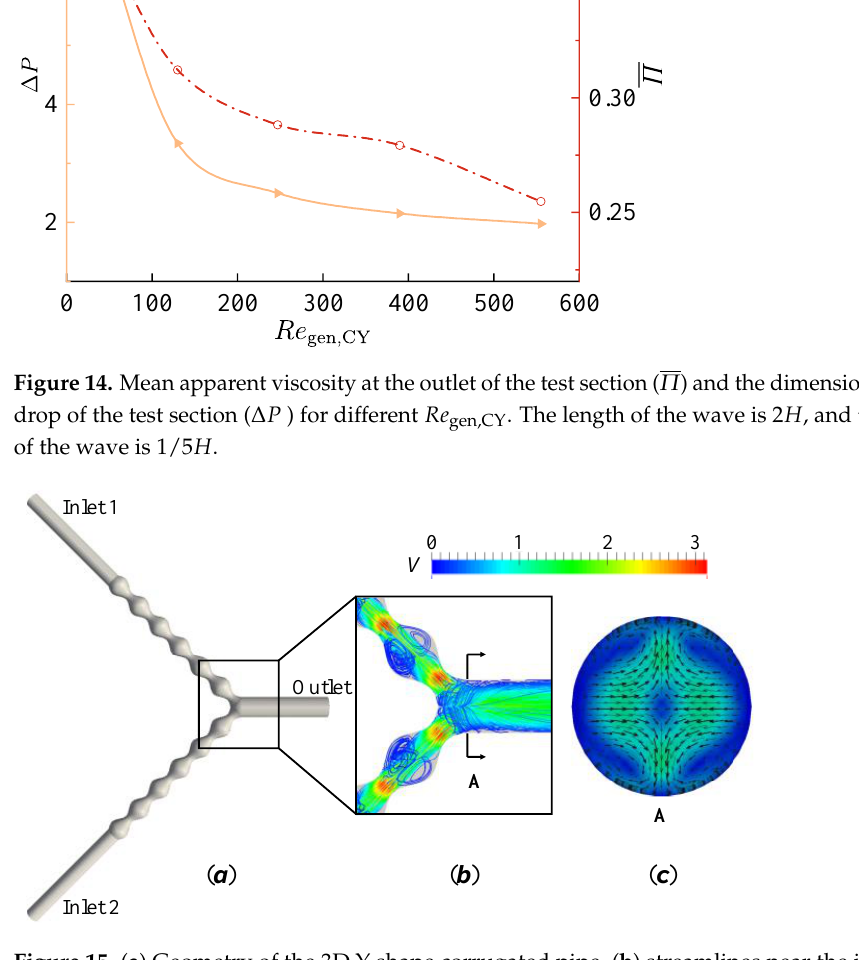
Figure 15. ( a ) Geometry of the 3D Y-shape corrugated pipe, ( b ) streamlines near the intersection of the two corrugated pipes and ( c ) the velocity vector in cross section A when 𝑉 in1 = 𝑉 in2 .